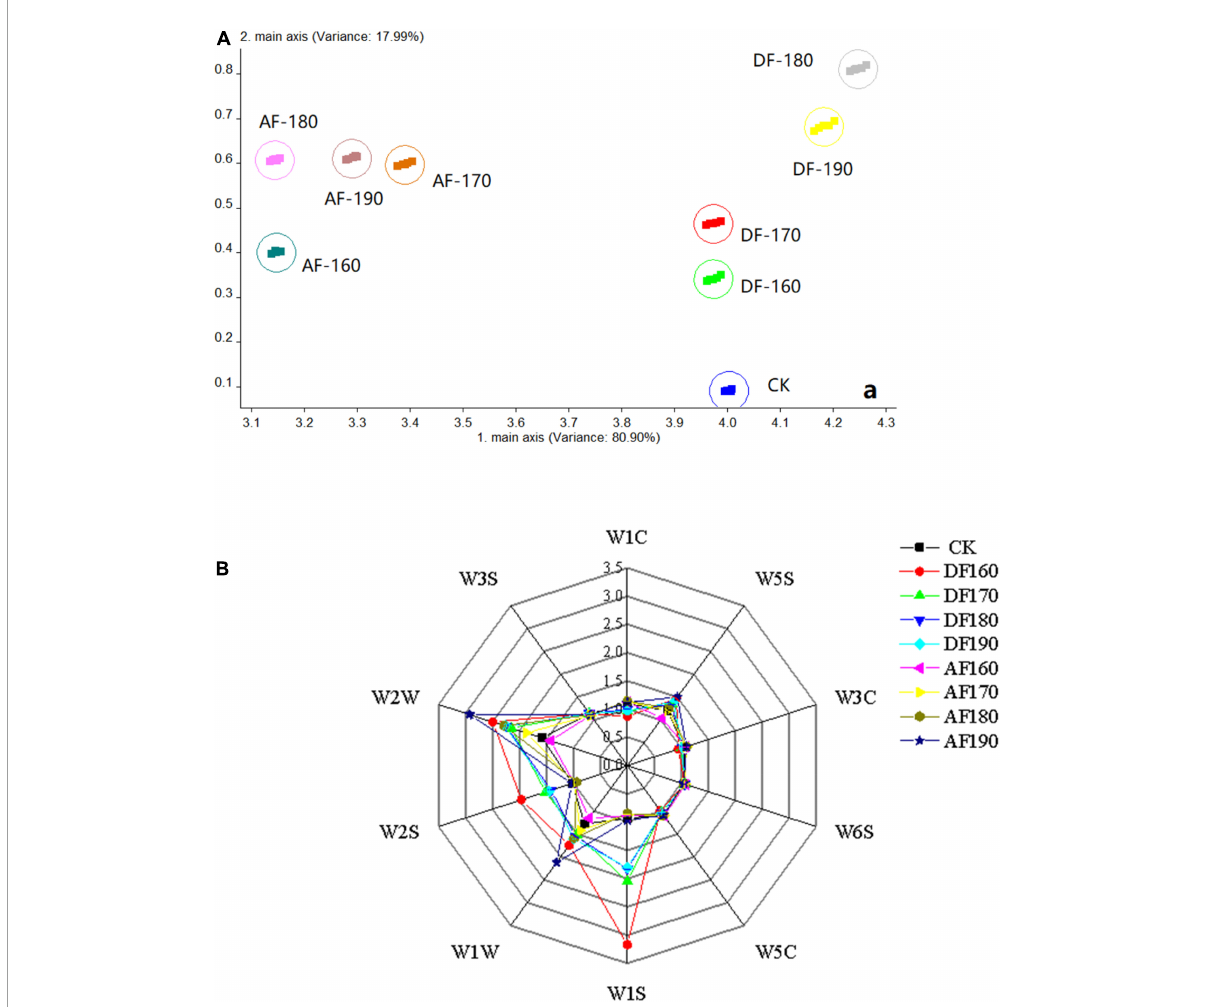
FIGURE1 Effect of frying method and temperature on the principal component analysis (PCA) of shrimp meat smell (A) and sensor signal value (B) . DF, shrimp meat was treated with deep frying; AF, shrimp meat was treated with air frying; 160, 170, 180, 190: The fried temperature of shrimp meat is expressed as 160, 170, 180, and 190 ◦